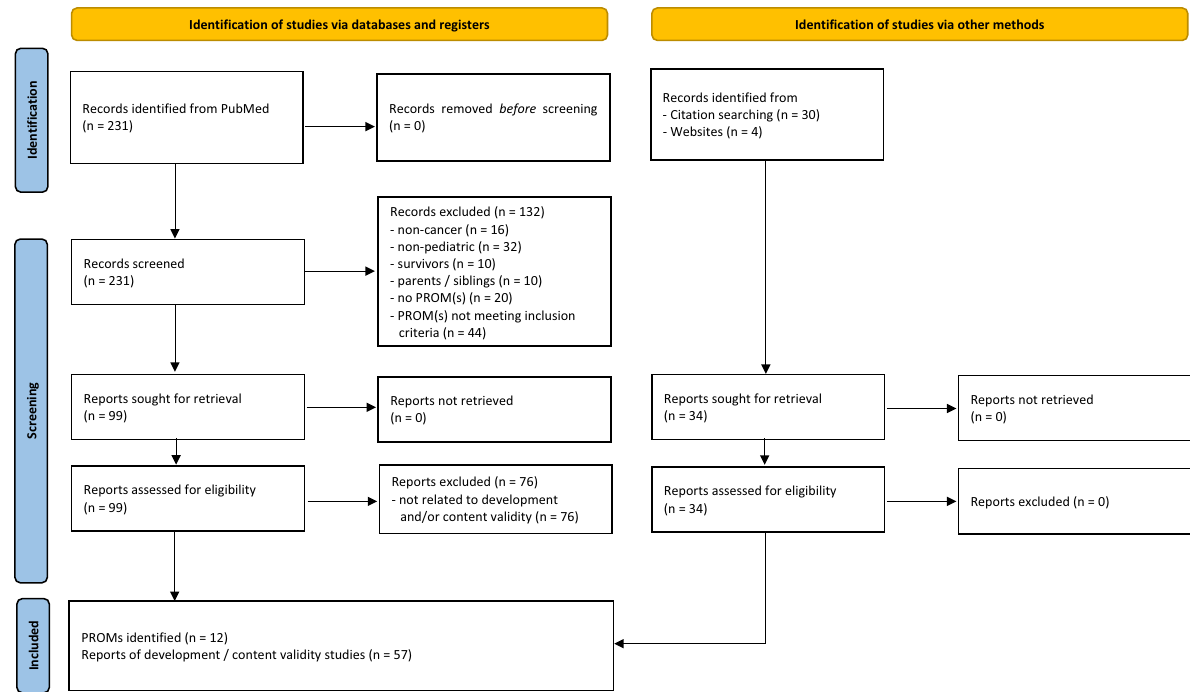
Fig. 1 PRISMA 2020 flow diagram of articles selection process. From: Page et al.